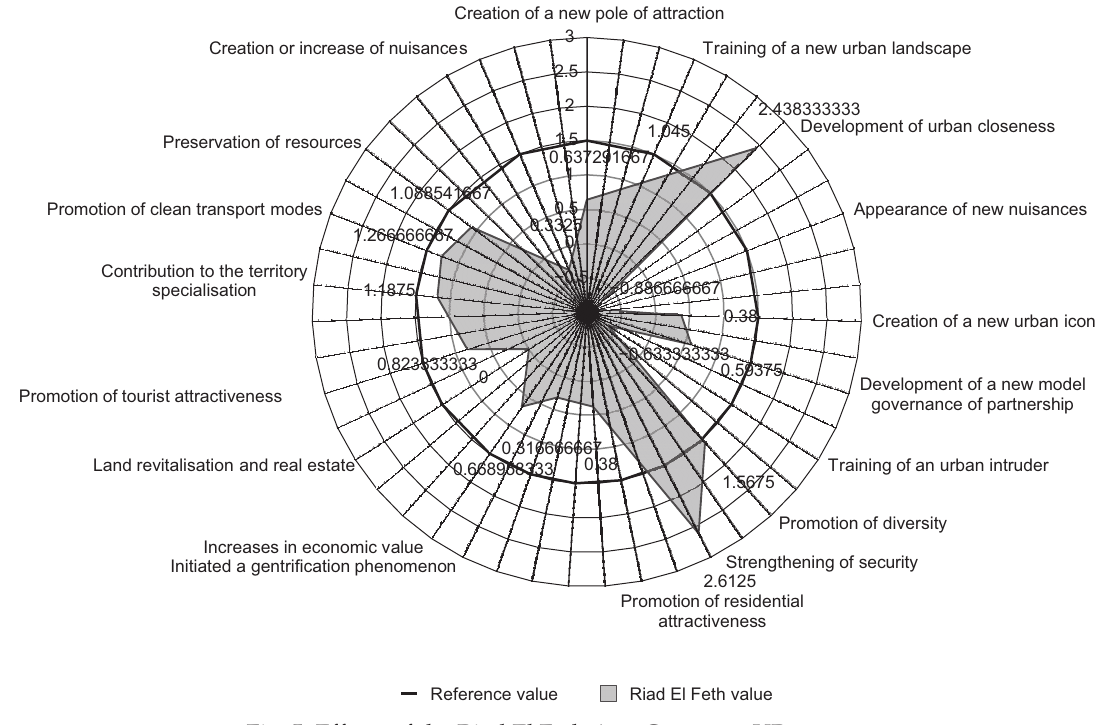
Fig. 5. Effects of the Riad El Feth Arts Centre on UR